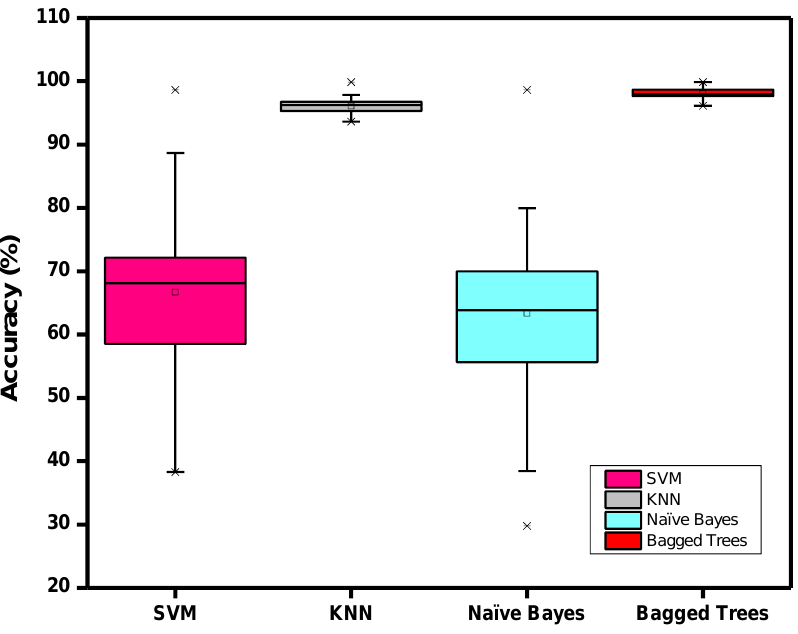
Figure 8. Comparison of the different machine learning algorithms.